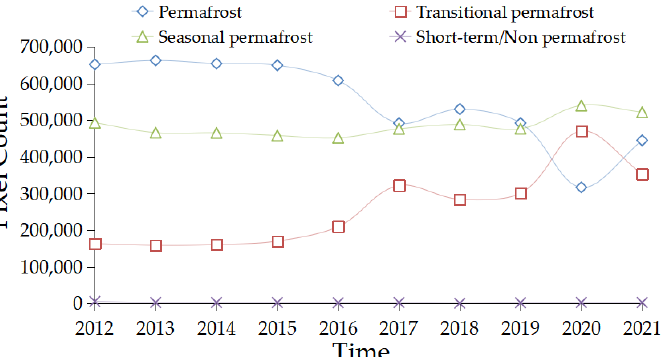
Figure 9. Total count of pixels for each class (permafrost, transitional permafrost, seasonal permafrost, and short-term/non-permafrost) for each year from 2012 to 2021.